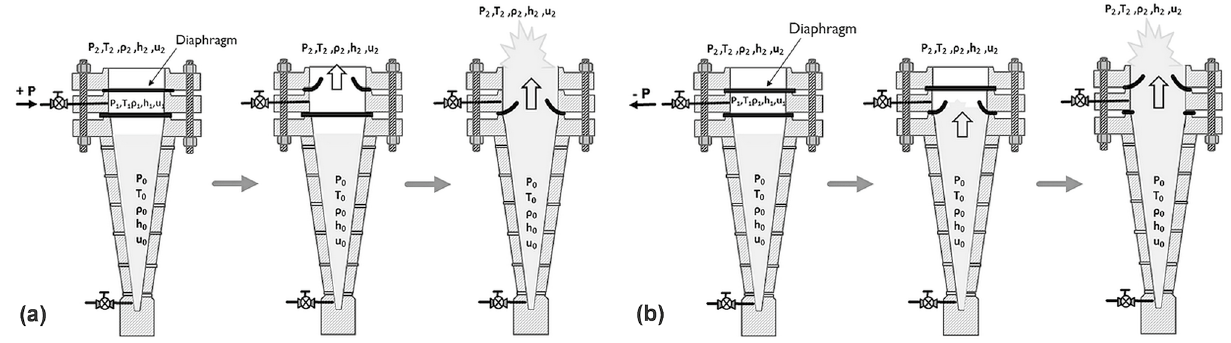
Fig. 2 Schematic drawing of the structure and stages of diaphragm rupture during the depressurization of liquified CO vessel. Increasing a and decreasing b the pressure in